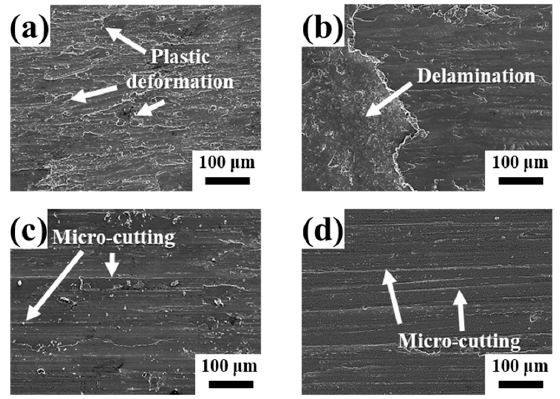
Figure 2. W s of test blocks against HSS rings obtained from wear tests under dry and wet